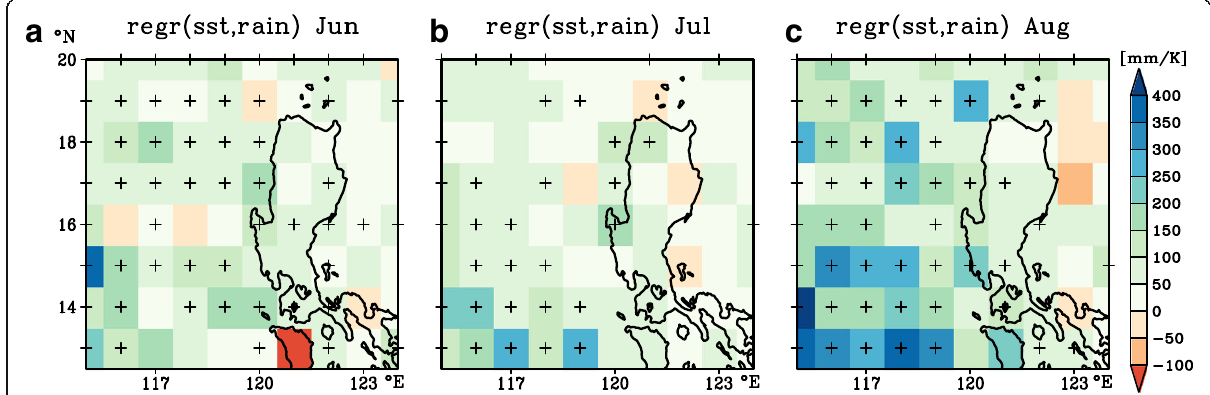
Fig. 5 Spatial map of the regression coefficients (mm K − 1 ) of the sensitivity of monthly rainfall to the monthly SST anomaly of the WSST reference region for 1982 – 2012 for the months of a June, b July, and c August. Significant values at the 90% significance level are marked with plus signs , as determined by the correlation coefficients based on 29 degrees of freedom. The rainfall anomalies were remapped to a 1° grid